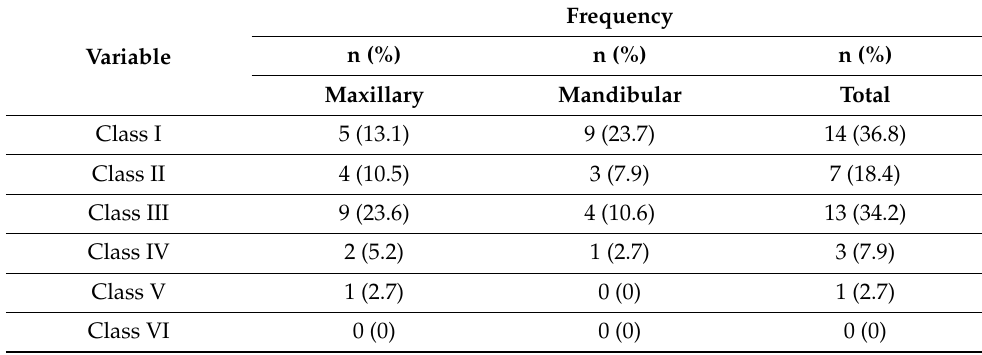
Table 1. Location of gingival pigmentation (Ponnaiyan’s classification).